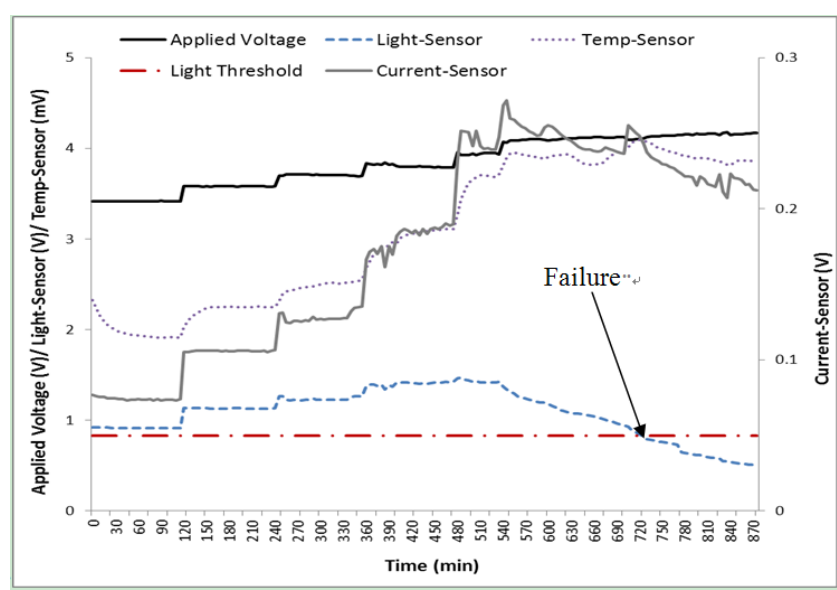
Figure 10. Sensor data from accelerated life test.